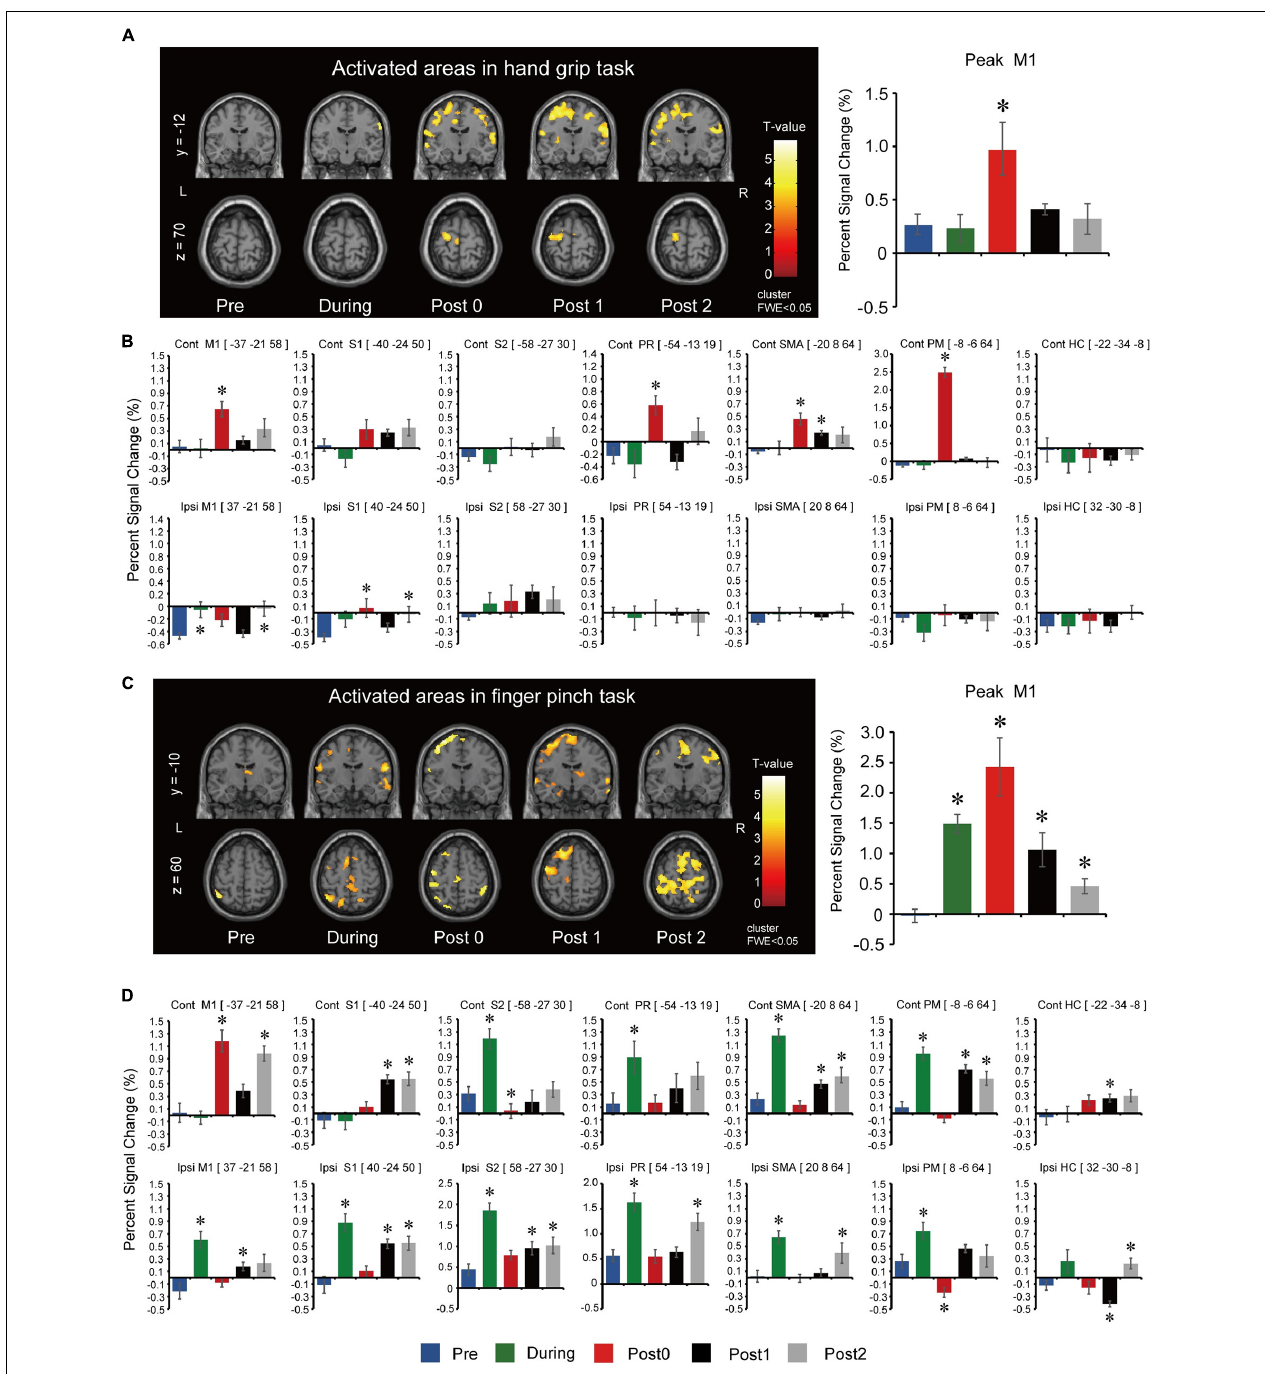
FIGURE 3 | Functional magnetic resonance imaging results for the long-term assessments during the hand grip task. (A) Activated regions in the left (L) and right (R) hemisphere during right (intervention) hand grip task. To observe the whole brain activity, the coordinates of y = –12 and z = 70 planes were used. T -values are plotted, and the threshold was set at voxel level p < 0.001 (uncorrected) and cluster level p < 0.050 [family-wise error correction (FWE)]. Assessments were carried out at baseline (Pre), after 6- and 12-weeks of FEST (During and Post0), as well as during follow-up assessments 6- and 12-weeks after FEST (Post1 and Post2). Region of interest (ROI) results of the most activated voxel in the primary motor cortex (M1) for each assessment are shown next to the activated regions. (B) ROI results based on anatomical regions in the M1 as well as the sensory cortex (S1), secondary somatosensory cortex (S2), parietal rostroventral area (PR), supplementary motor area (SMA), premotor cortex (PM), and the hippocampus gyrus (HC). The upper bar graphs show activity of the contralateral hemisphere (Contra) and the lower bar graphs shows activity of the ipsilateral hemisphere (Ipsi). fMRI during the finger pinch